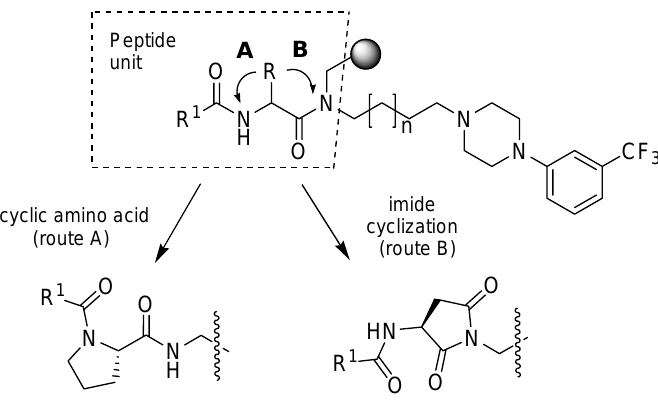
Figure 3. General structure of the target compounds A and B obtained via modification of the peptide unit